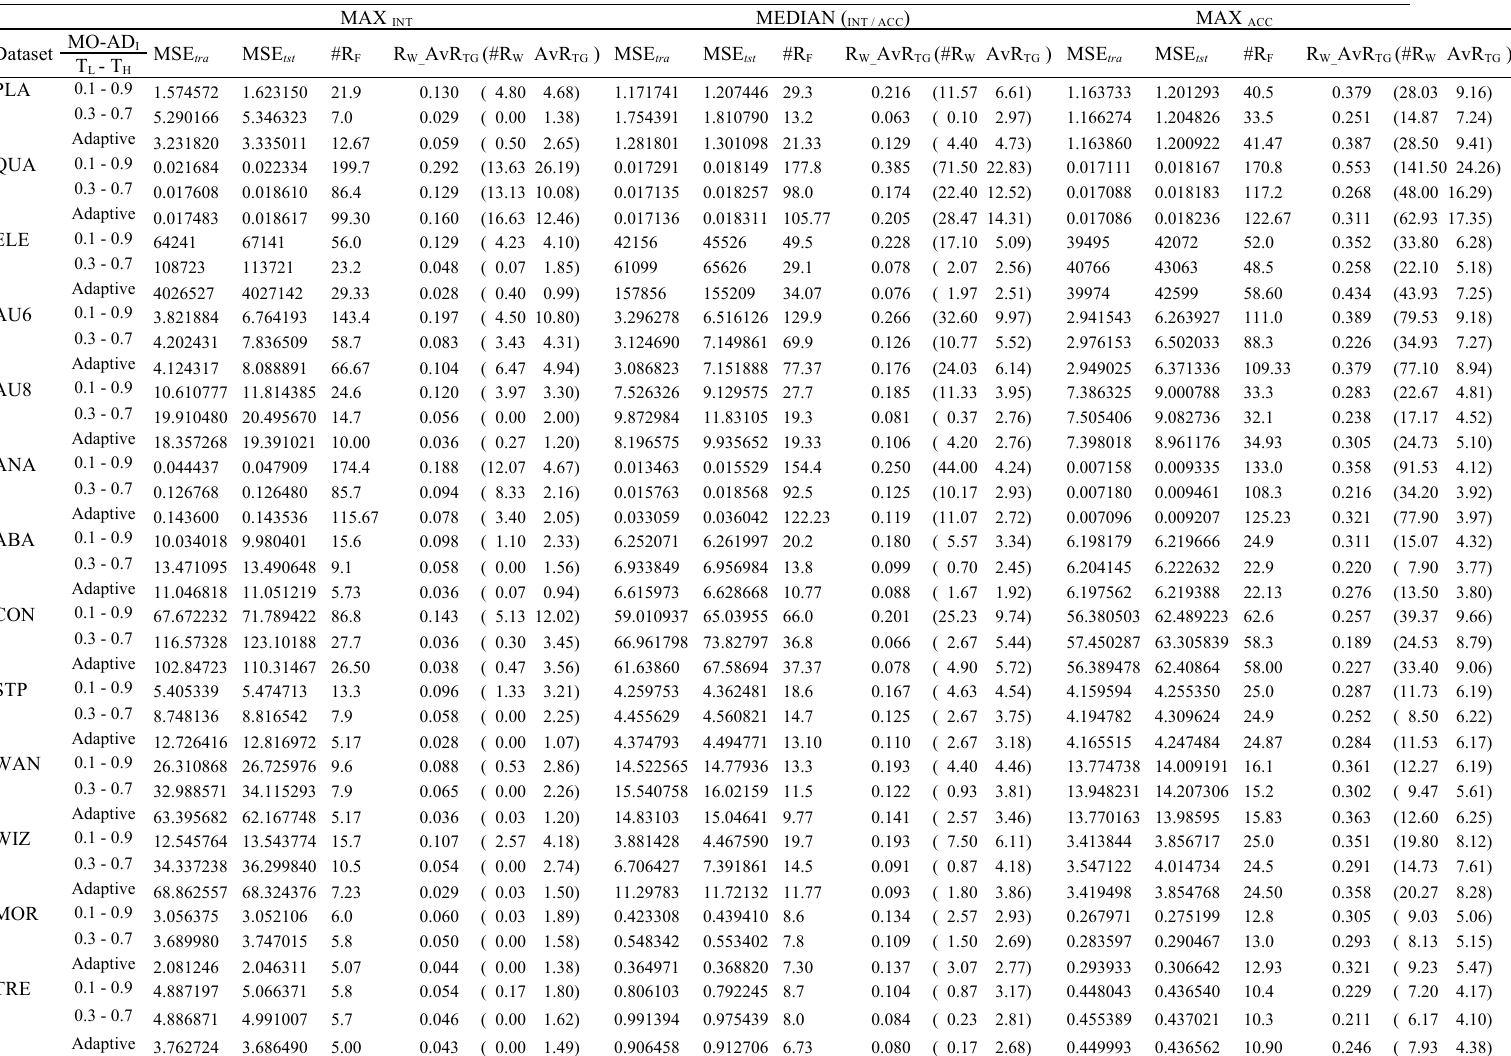
Table 10. Results obtained by MO-AD I for different configurations of thresholds using the FS_MOGUL rule